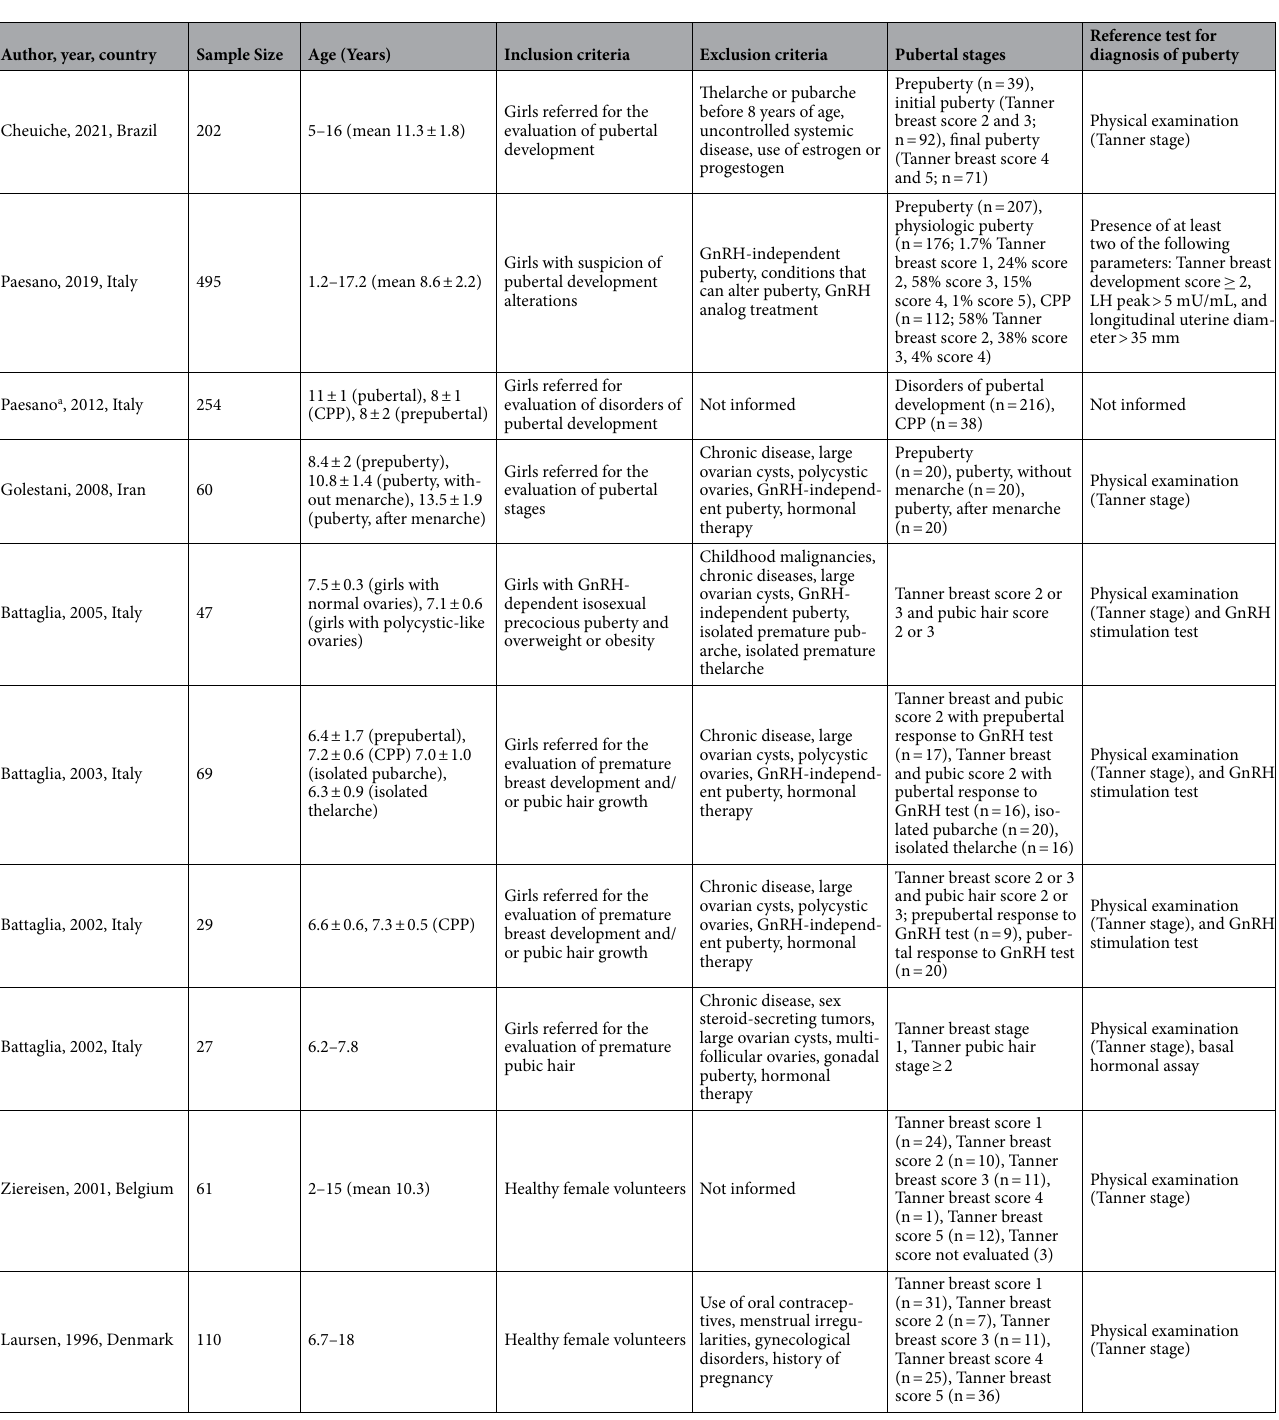
Table 1. Characteristics of the included studies. a Published in conference